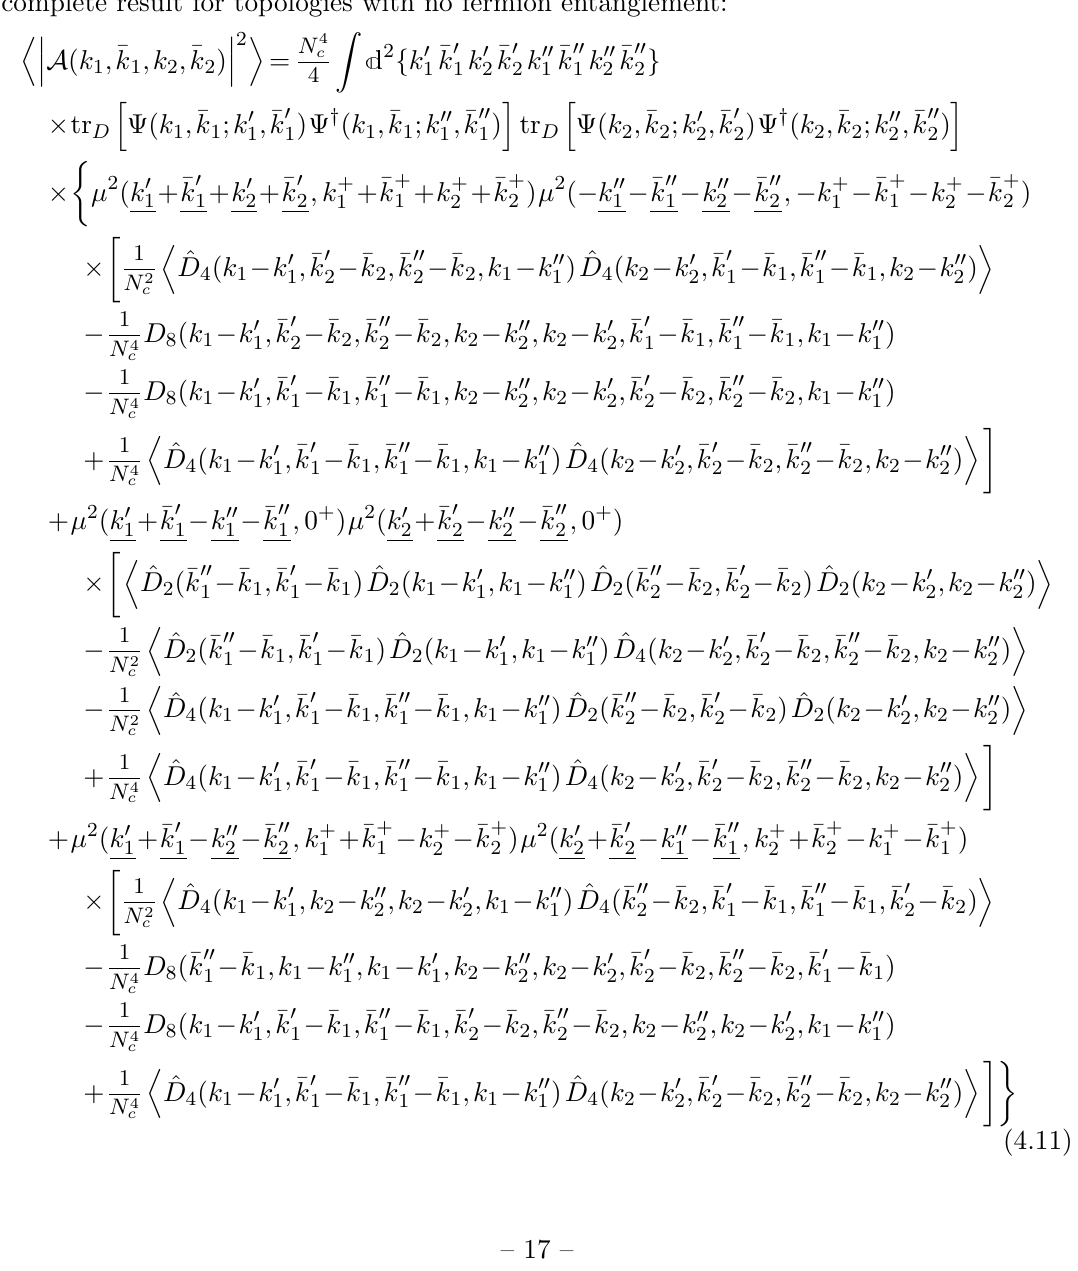
Figure 5 . Illustration of the Wilson line traces D 8 contributing to double-pair production in eqs. (4.11) and (4.16). complete result for topologies with no fermion